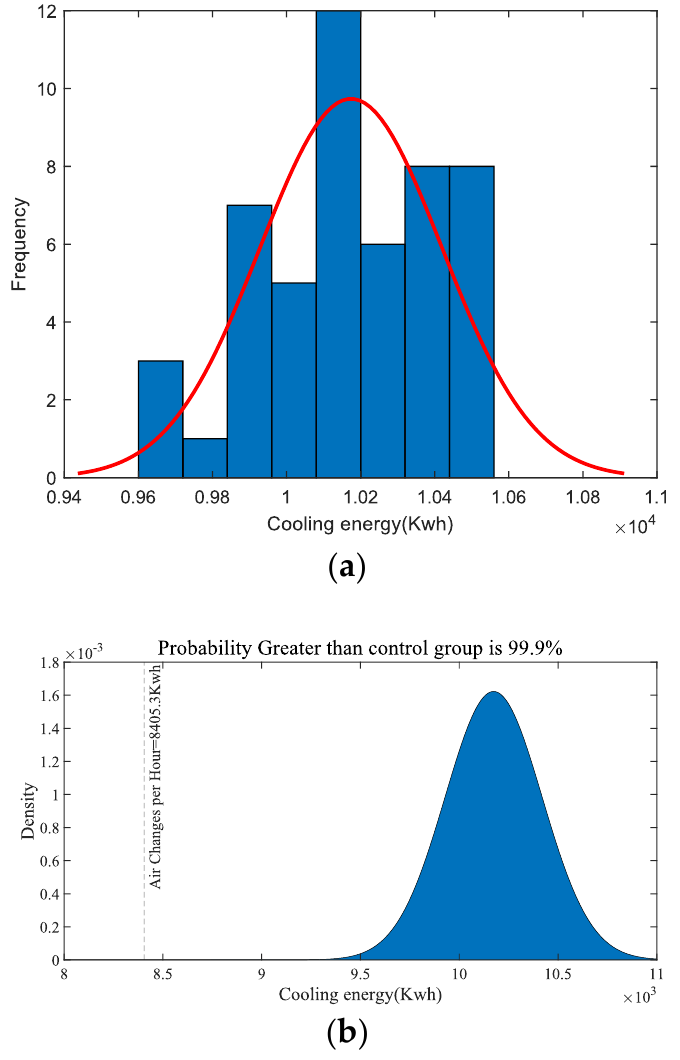
Figure 10. Building energy consumption. ( a ) Cooling Energy consumption distribution (The red line is the Gauss Distribution). ( b ) Comparison of cooling energy consumption.